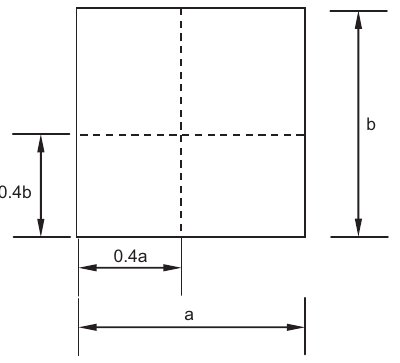
Figure 4 Laminated plate with intermediate line supports in each direction.